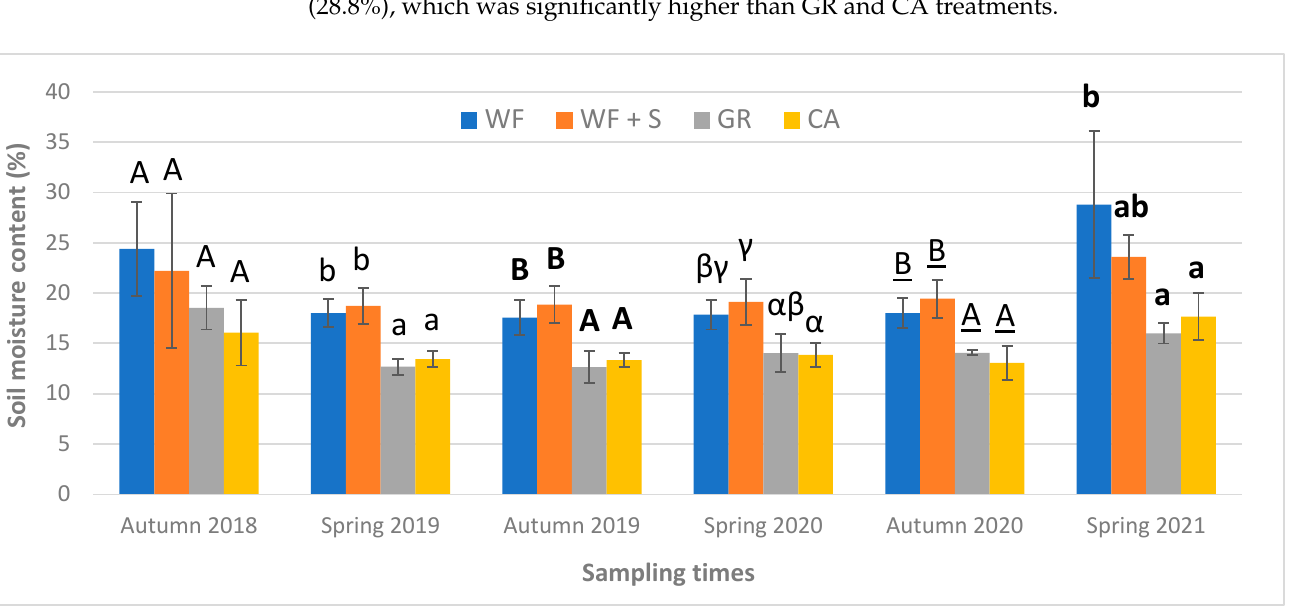
Figure 3. Soil moisture content between autumn of 2018 and spring of 2021. Same letters above bars mean no statistical difference. Results of each sampling times were analyzed separately from each other, so each set of results per sampling time was marked with a different type of letter. (WF: weed control fabric; WF + S: weed control fabric and straw; GR: grass vegetation; CA: cultivated alfalfa).